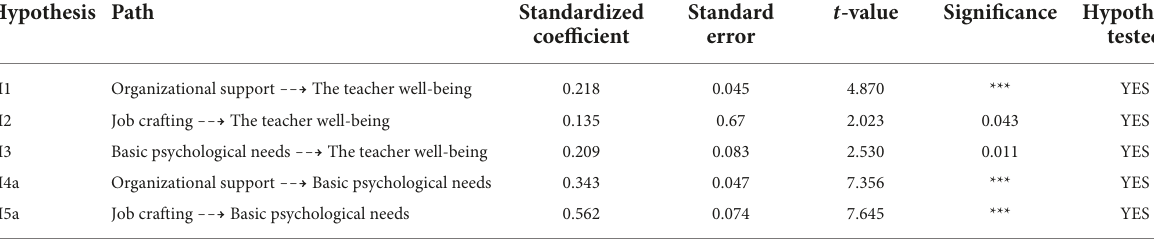
TABLE 6 Intermediary effect testing.